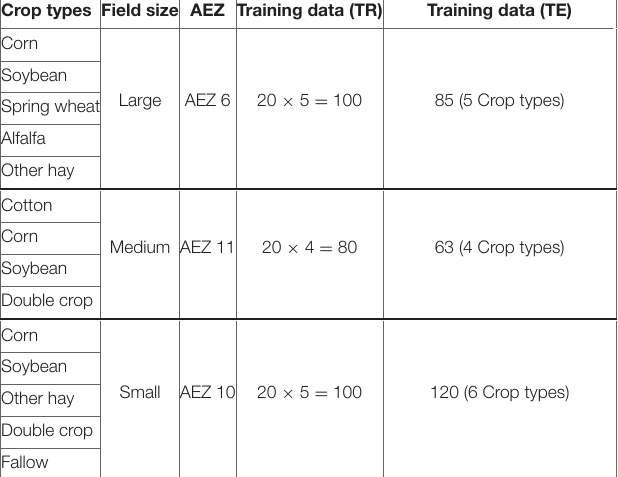
TABLE 1 | The training data collected from the 2015 CDL of the TR regions to classify the crop type maps of the TR and TE regions. Crop types Field size AEZ Training data